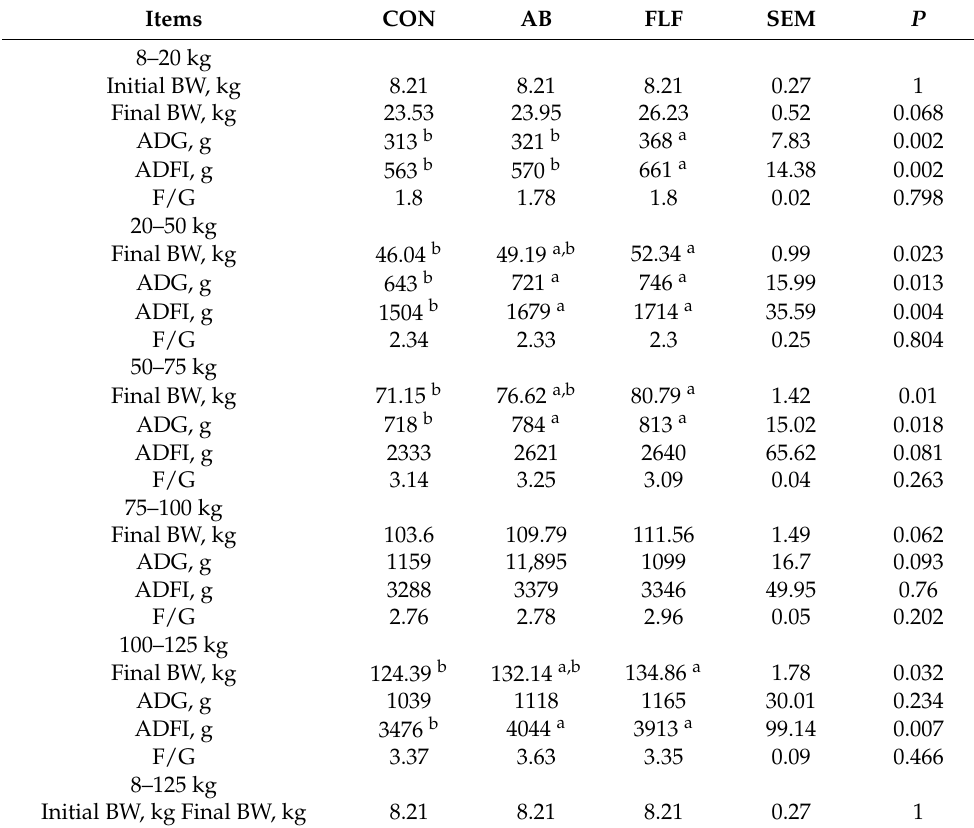
Table 4. Effects of fermented liquid feeding on the growth performance of